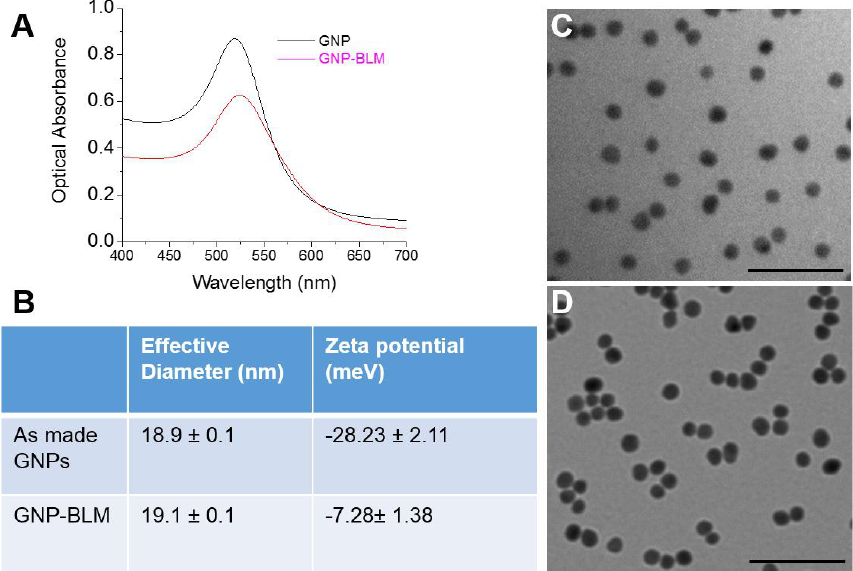
Figure 1. Characterization of gold nanoparticle-bleomycin (GNP-BLM) vs. as made (citrate-capped) GNPs. ( A ) Ultraviolet-visible absorption spectra of as made GNP and GNP-BLM; ( B ) Hydrodynamic diameter and zeta-potential of as made GNPs and GNP-BLM; ( C , D ) Transmission electron microscopy (TEM) images of as made GNPs and GNP-BLM, respectively. The scale bar is 100 nm.